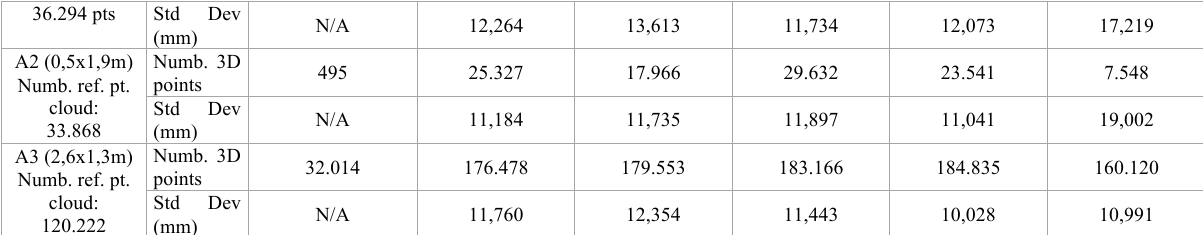
GREEN2GRAY Adobe REALTIME VisualSFM (VSFM)